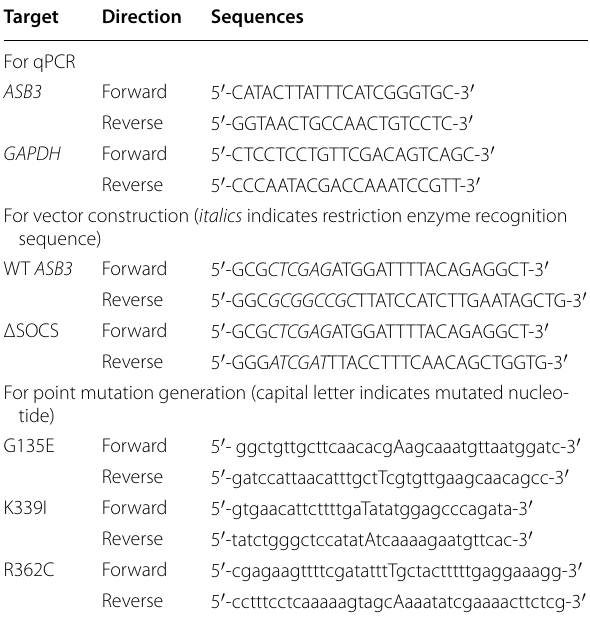
Table 2 The sequences of primers used in this